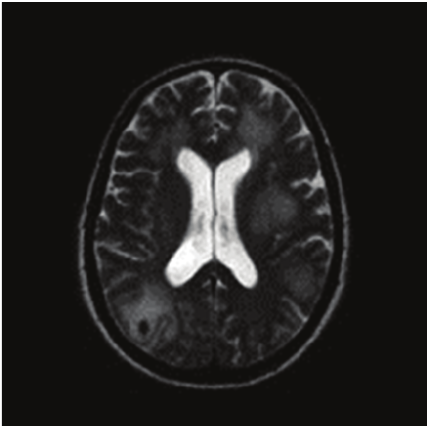
Figure 1: Multiple hemorrhagic foci in bilateral cerebral hemi- spheres on